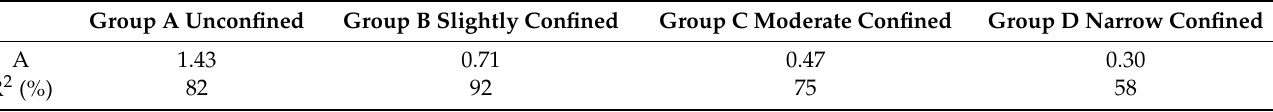
Figure 12. Extracted exponential fitting curves of bond loss as a function of average crack width, for each confinement level group. ( a ) Unconfined specimens, ( b ) Slightly confined specimens, ( c ) Moderate confined specimens, ( d ) Narrow confined specimens. Table 5. Parameters determined by regression analysis for the exponential predictive model. Group A Unconfined Group B Slightly